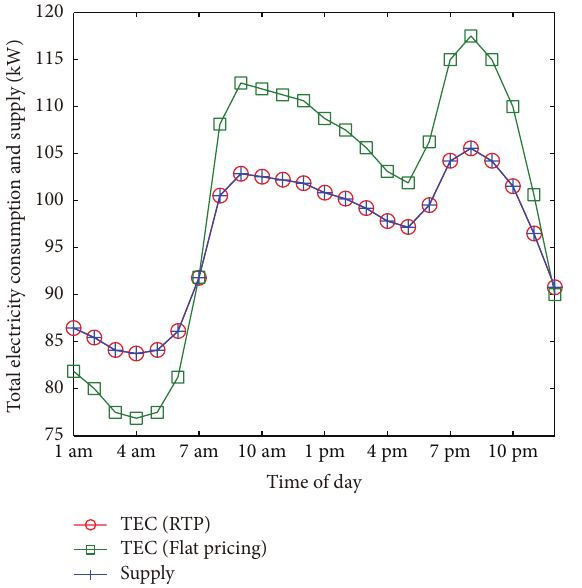
Figure 4: Total electricity consumption (TEC) and supply in a day.